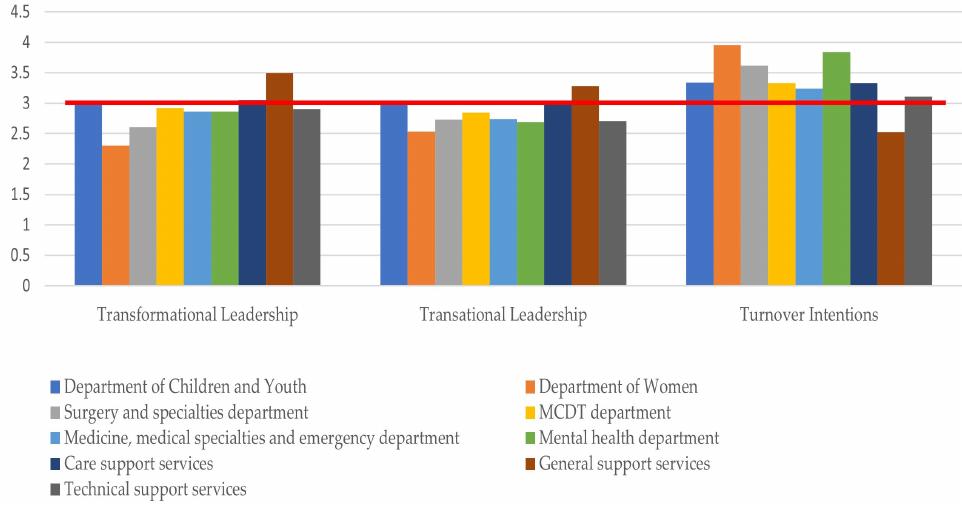
Figure 5. Leadership and Exit Intentions by department.